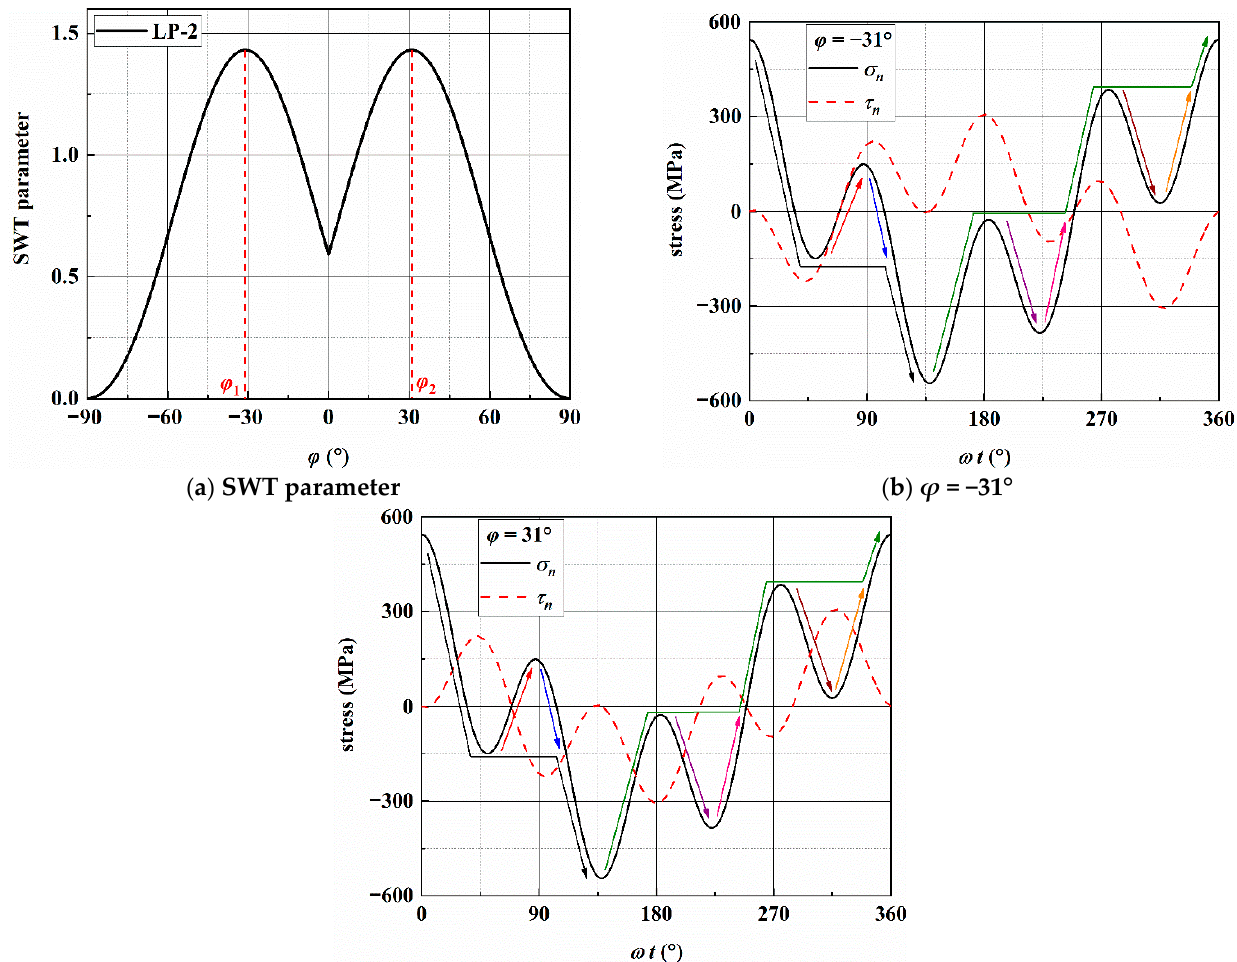
Figure A7. The procedure and results of BS with SWT method for reversal extraction under LP-2.